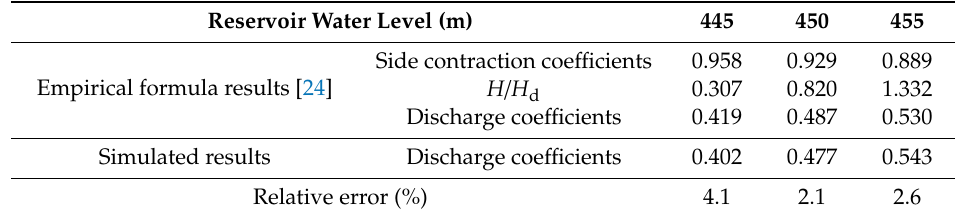
Table 2. Relative error between the simulated results and empirical formula results with different lattices. Table 1. Comparison of the discharge coe ffi cients between the simulated results and the empirical formula